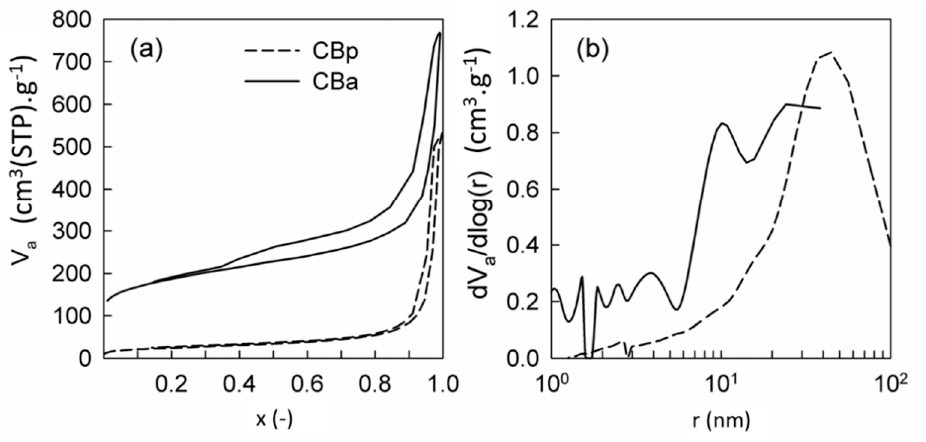
Figure 3. ( a ) Measured nitrogen adsorption-desorption isotherms at 77 K and ( b ) evaluated pore-size distributions of prepared carbon blacks.